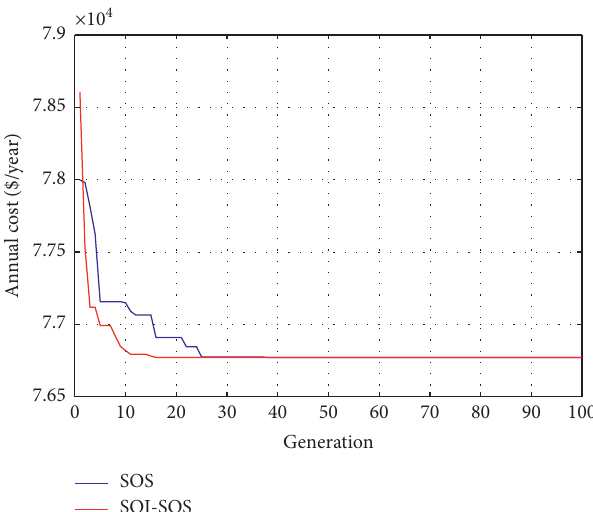
Figure 6: Convergence curves of the total cost of the 33-bus system with the mixed load model.